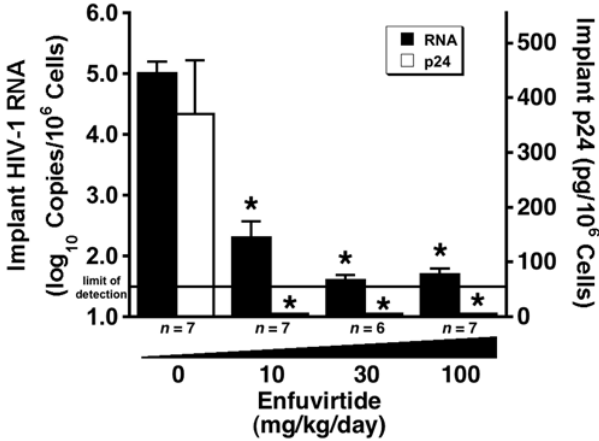
Figure 7. T-20 causes dose-dependent reductions in viral load in HIV- 1 NL4-3 D36G-infected SCID-hu Thy/Liv mice. Mice were treated by twice-daily subcutaneous injection with T-20 at 10, 30, and 100 mg/kg per day beginning on day 2 1. Antiviral efficacy was assessed by determining cell-associated HIV-1 RNA and p24. Data are expressed as means 6 SEM; *p # 0.05 for treated mice versus untreated mice by the Mann-Whitney U test for the number of mice indicated under each bar.